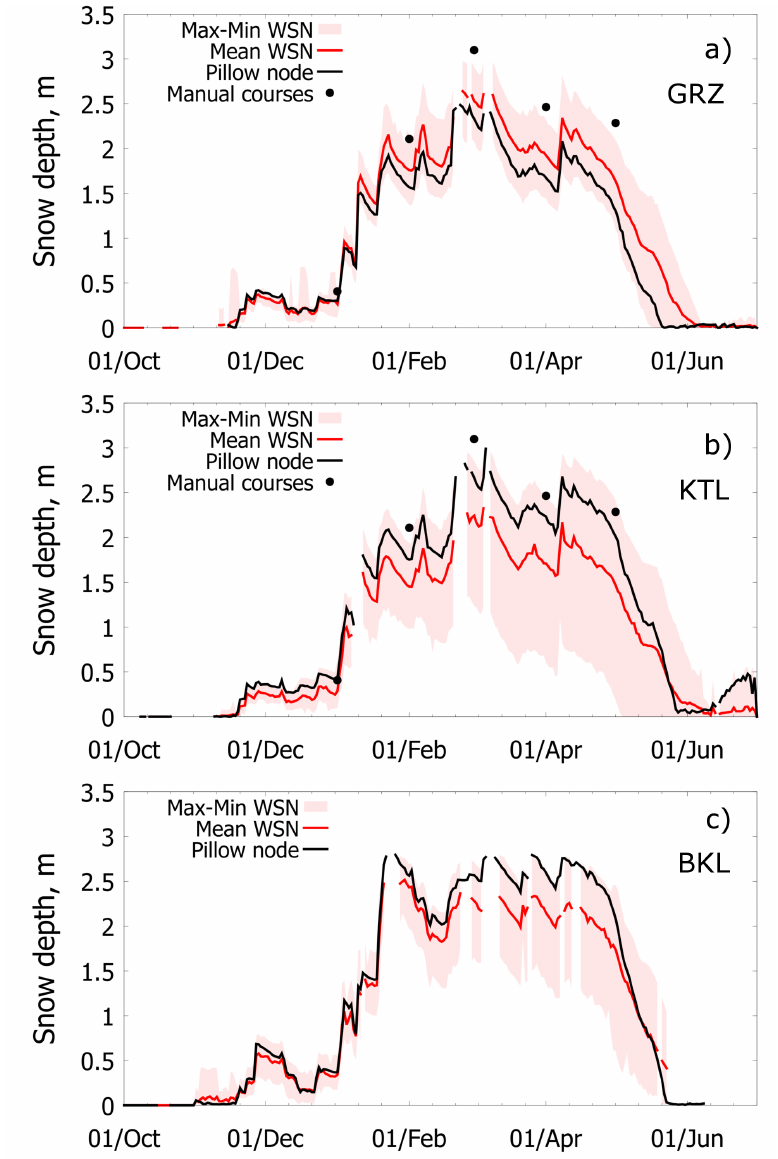
Figure 10. Comparison between snow depth measurements from the WSNs (red) with manual measurements taken by monthly snow courses (dotted black) at the same locations for Grizzly Ridge ( a ), Kettle Rock ( b ) and Bucks Lake ( c ) (no snow courses are done at the Bucks Lake